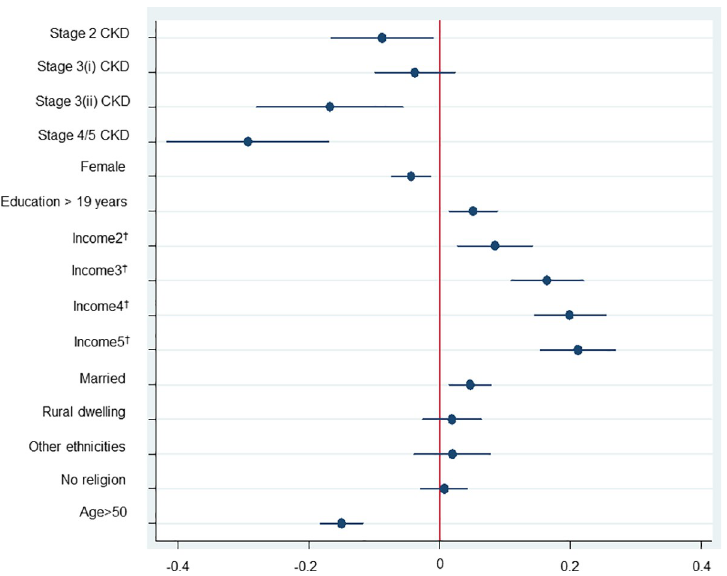
Fig 2. Multivariable Tobit model exploring the relationship between CKD severity and HRQoL (the base case model). Note: †: Income2 ( > £11,142.86 & � £19,090.91), Income3 ( > £19,090.91 & � £29,166.67), Income4 ( > £29,166.67 & � £45,138.89), Income5 ( > £45,138.89); (i) Stage 3 CKD without albuminuria, (ii) Stage 3 CKD with albuminuria. Bar represents 95% Confidence Intervals (CI), Dot represents the coefficient of the multivariable Tobit